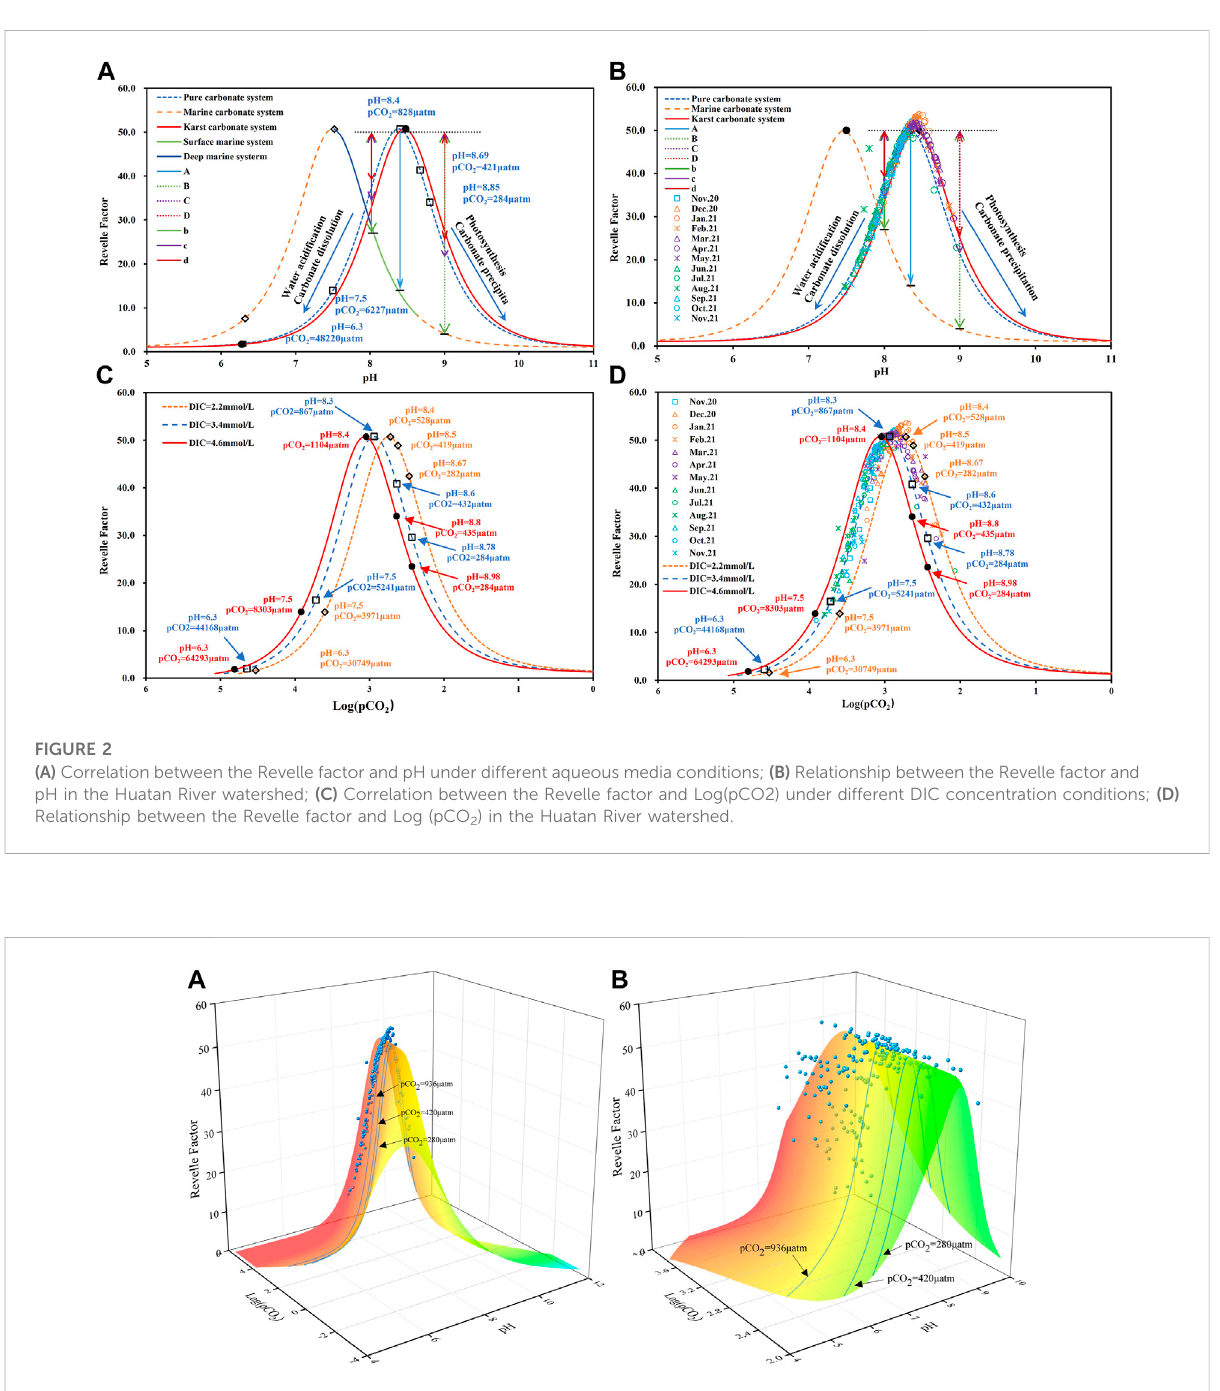
FIGURE 3 Three-dimensionalrelationship amongtheRevellefactor,pH,andLog(pCO2)forgivenrangesofpH(4 – 12)andLog(pCO2)( − 4~6).Thethree light-blue lines represent atmospheric CO2 concentrations (280 μ atm, 420 μ atm, and 936 μ atm) under different RCP scenarios. The blue dots represent thedistribution ofsampling sitesintheHuatanRiverover13 months.Most ofthedatapoints arelocated intheinterval ofpH < 8.4 andLog (pCO2) > 3.04, indicating the buffering of H+ by CO2 degassing, while the data points in the range of pH > 8.4 and Log (pCO2) < 3.04 re fl ect the uptake of atmospheric CO 2 . The distribution of the data points in the Huatan River is mainly in the range of Log (pCO 2 ) between 2 and 4. As a result, (B) is an enlarged version of part of the area in (A)